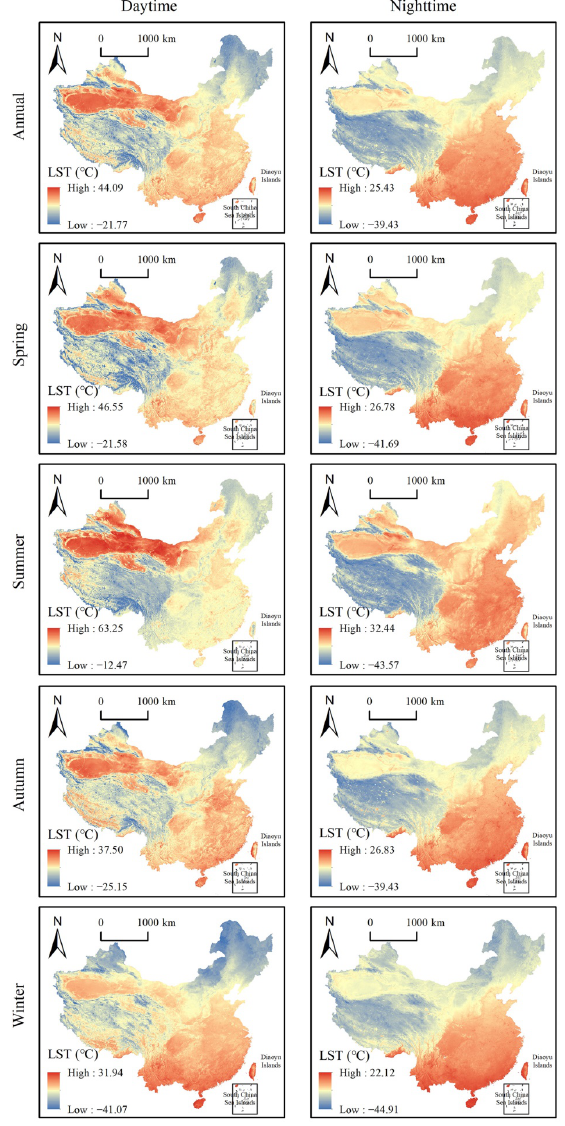
Figure 3. Land surface temperature (LST) spatial distribution maps.